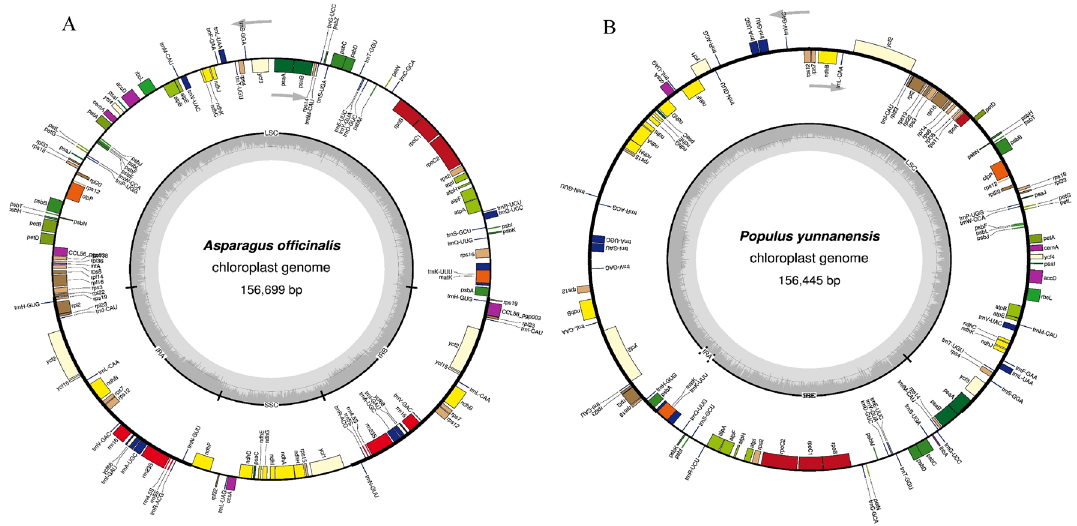
Figure 2. OGDRAWM map of ( A ) Asparagus officinalis (NC_034777.1) and ( B ) Populus yunnanensis (NC_037421.1) chloroplast genomes. ( A ) Asparagus officinalis shows the presence of a putative spacer tRNAs. tRNA Ala (UGC) and tRNA Ile (GAU) are present between 16 and 23S rRNA in A. officinalis . No putative spacer tRNA is found in the chloroplast genome of Populus yunnanensis .